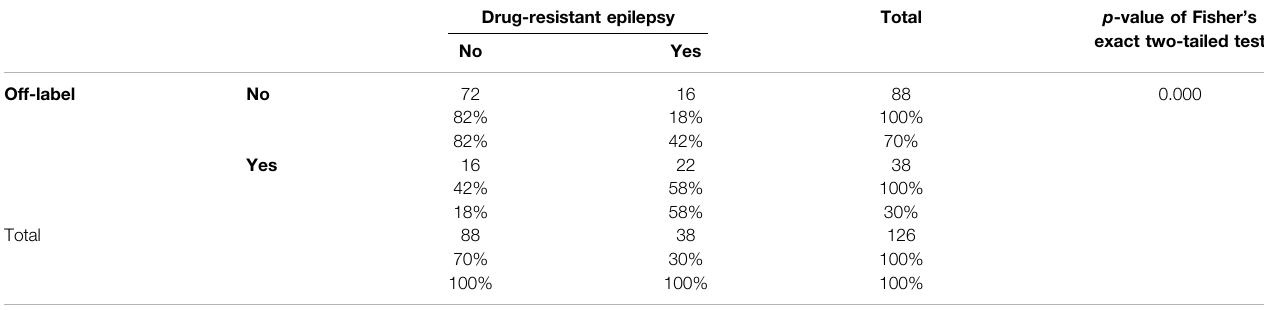
TABLE 5 | Two-way relative frequency table between off-label prescriptions and drug-resistant epilepsy.